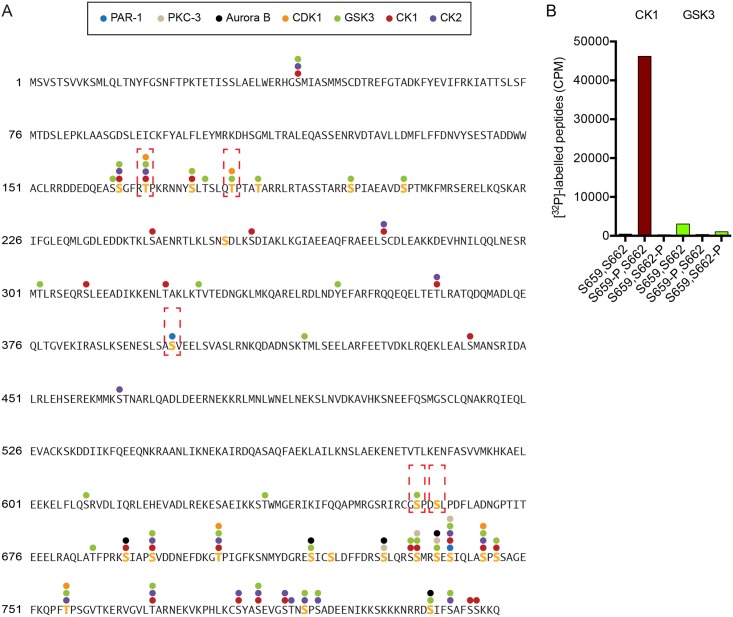
LIN-5 phosphorylation by cell cycle and polarity kinases in vitro.(A) Graphic overview of mass spectrometry analysis of in vitro kinase assays, revealing multiple target residues in LIN-5 phosphorylated by PAR-1, PKC-3, CK1, CK2, GSK3, CDK1 and Aurora B kinase. Yellow residues indicate in vivo phosphorylated residues, brackets indicate essential residues identified in complementation assay. (B) Radioactive counts (CPM) of in vitro kinase assays with CK1 and GSK3 on a synthetic LIN-5 peptide 654–670 with or without synthetic incorporation of phosphorylated amino acids S659 or S662.